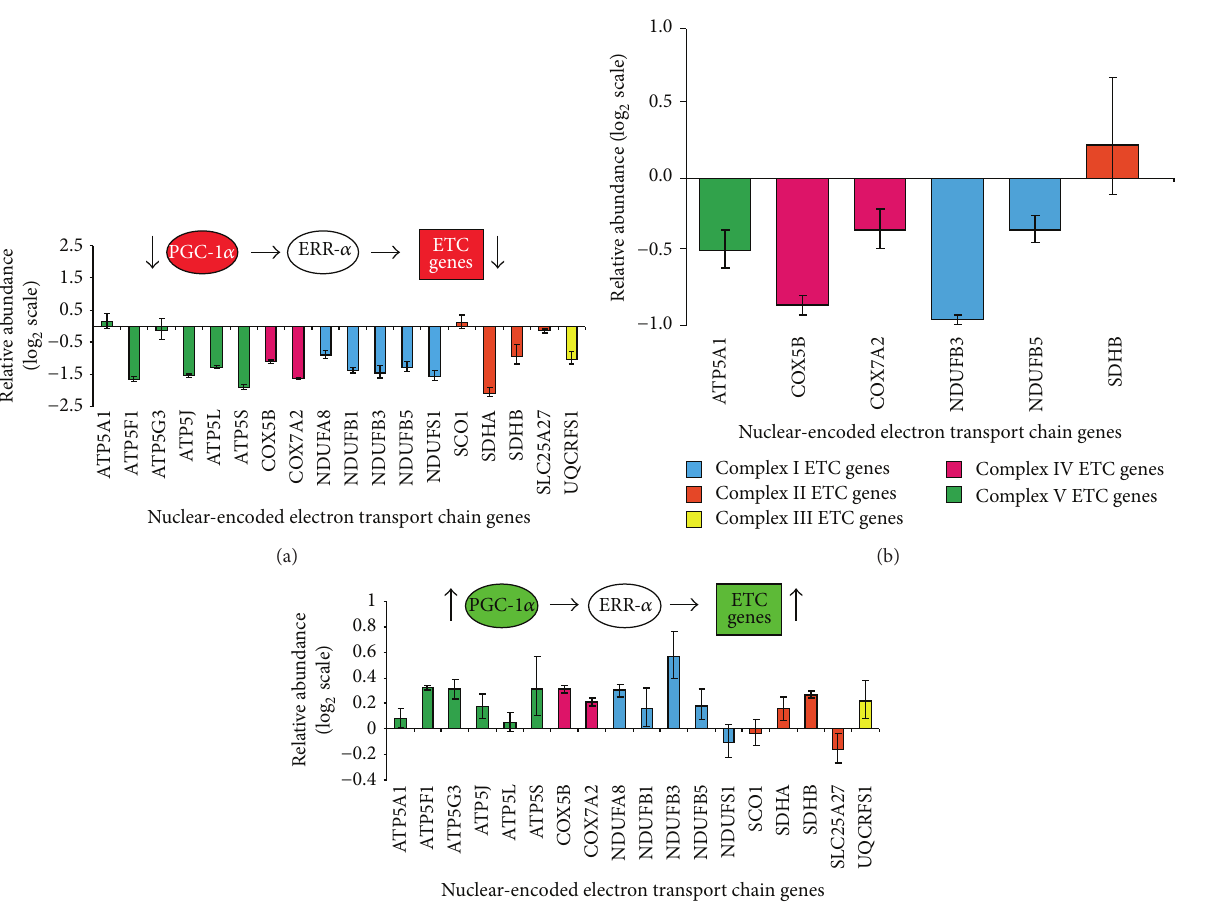
Figure 1: Endogenous PGC-1 𝛼 regulates the nuclear-encoded electron transport chain genes in neuronal cells and in mice. (a) Silencing of endogenous PGC-1 𝛼 repressed the expression of nuclear-encoded electron transport chain genes representing complexes I, II, III, IV, and V of the electron transport chain in SK-N-MC cells by quantitative PCR analysis (note log 2 scale). Model circuit and observed effects in circuit components are shown (top). Subunits of complexes I to V of the electron transport chain are color-coded in panels (a)–(c) in accordance with the color legend shown in (b). Means ± SEM are shown ( 𝑁 = 3 for each treatment). The ribosomal gene RPL13 was used to control for input RNA. (b) Expression of representative electron transport chain genes was similarly reduced in brain of PGC-1 𝛼 null mice [21] compared to age- and sex-matched wild-type littermates ( 𝑁 = 3 ). The ribosomal gene RPL13 was used to control for input RNA. (c) Transduction with adenovirus carrying PGC-1 𝛼 trans -activated the expression of endogenous genes encoding nuclear subunits of complexes I, II, IV, and V of the mitochondrial respiratory chain in SK-N-MC cells compared controls transduced with the LacZ gene. Model circuit and observed effects in circuit components are shown